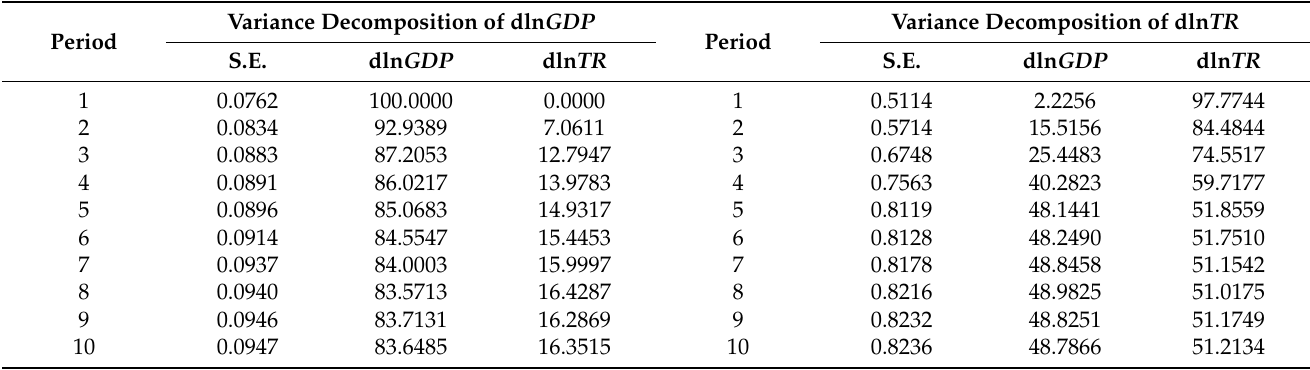
Table 5. Variance decomposition table of economic growth rate of Ganzi Prefecture and tourism comprehensive income growth rate of Hailuogou scenic